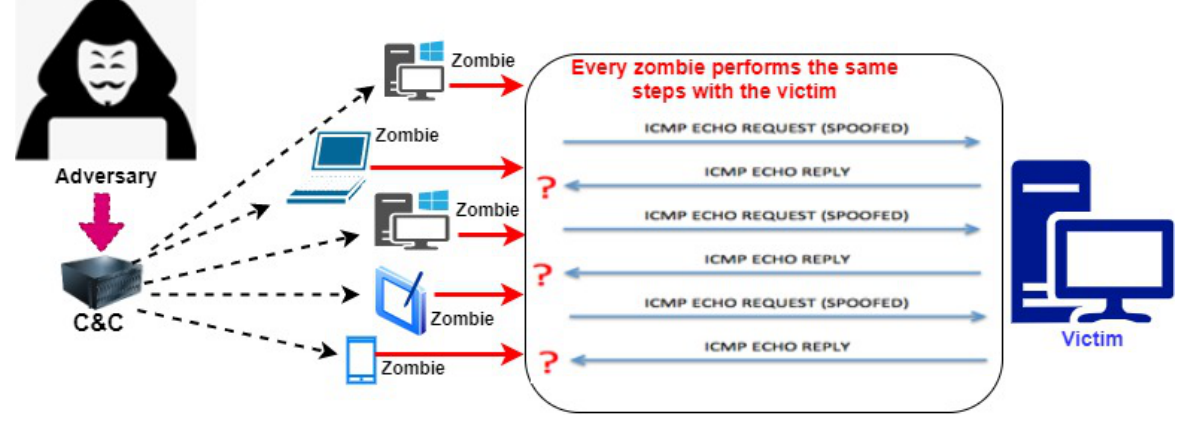
Figure 7. ICMP flood